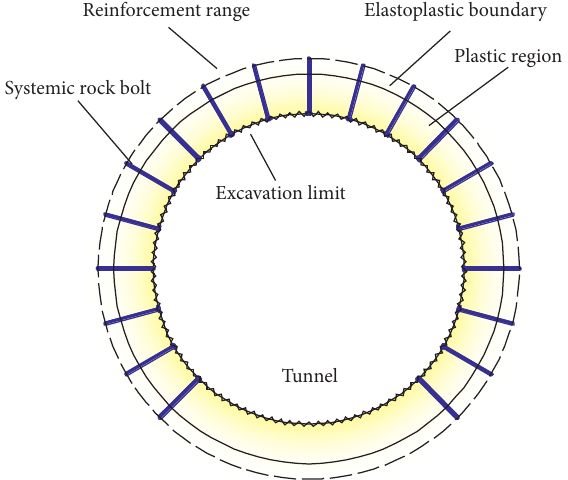
Figure 3: Reinforcement range and plastic region. Table 2: Bias parameters to calculate allowable displacement.